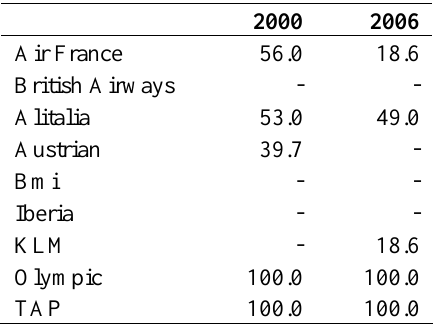
Table 6. Public ownership of airline companies